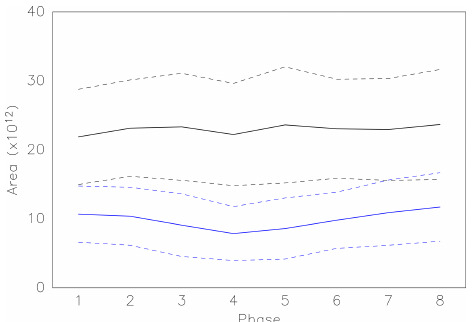
Figure 13. Mean values (solid curves) and the ranges of standard deviation (broken curves) of the area of thickness-weighted low- PV air (kgK − 1 ) calculated at the 370K level for each of the eight phases. Black and blue curves correspond to the total area and the partial area westward of 60 ◦ E,